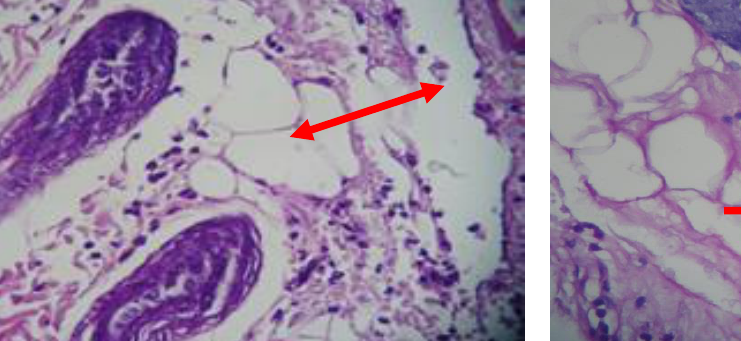
Figure, 9a: Histological section in the skin of infected non- immunized animal at day 30 post challenge showed hypodermal odema with eosinophilic infiltration and congested blood vessel (H&E stain 400X).